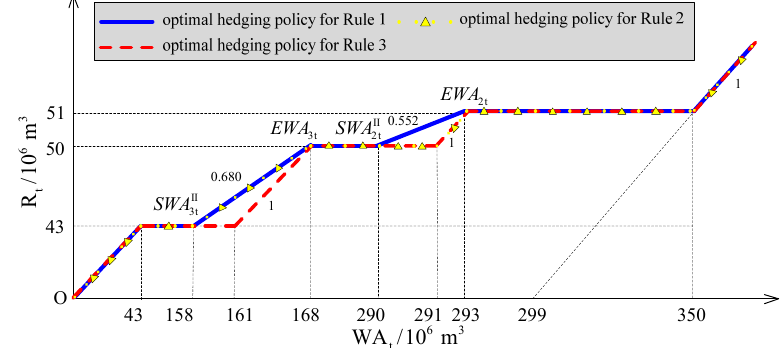
Figure 12. The operation policy in July obtained using the proposed rule .